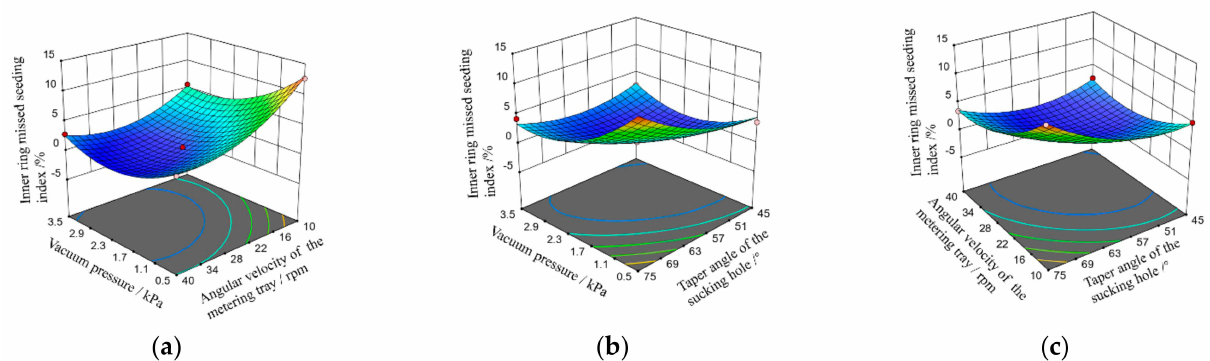
Figure 6. Effect of ( a ) angular velocity of metering tray and vacuum pressure, ( b ) taper angle of sucking hole and vacuum pressure, and ( c ) taper angle of sucking hole and angular velocity of metering tray on the inner ring missed seeding index.